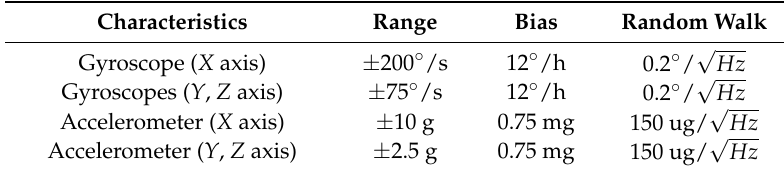
Table 1. Parameters of the Inertial Measurement Unit (IMU) before the Semi-strap-down Stabilized Platform (SSP) is optimized.